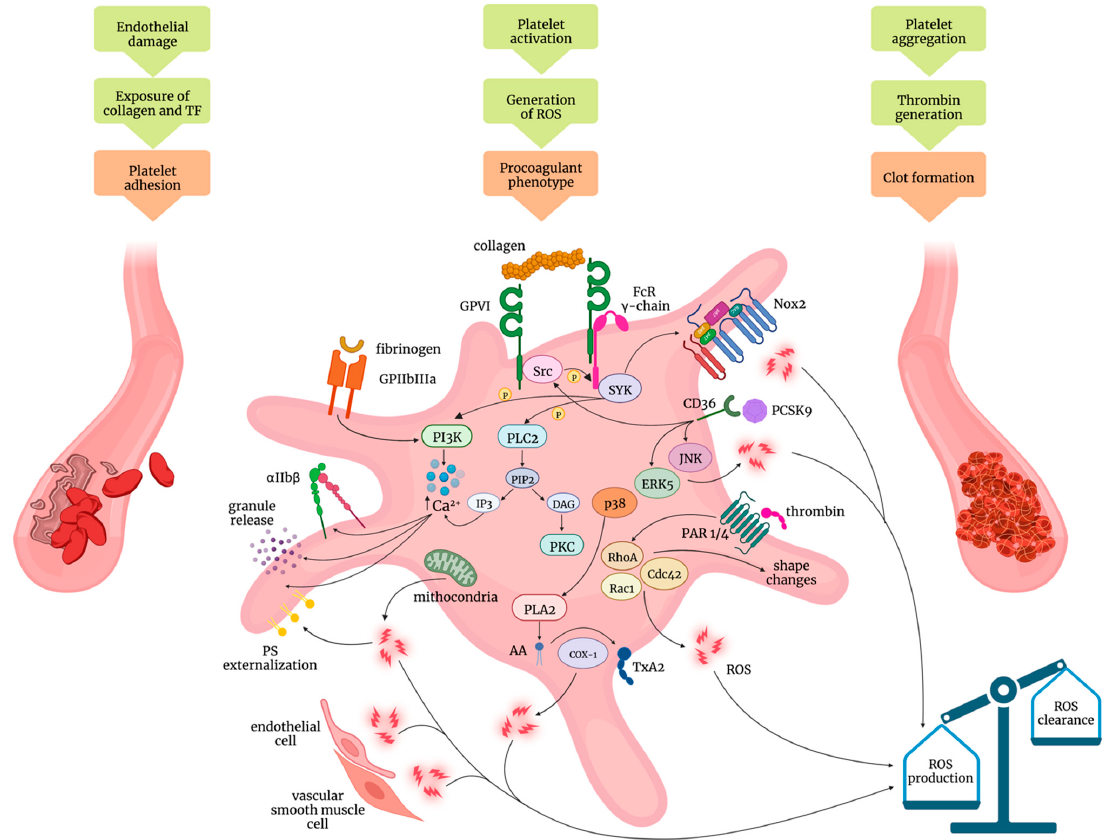
Figure 1. Platelet redox imbalance leading to a prothrombotic state. Major signalling pathways involved in platelet activation and increased ROS production. The imbalance between ROS production and ROS clearance causes oxidative stress and contributes to the generation of a prothrombotic state. Abbreviations: TF: tissue factor; ROS: reactive oxygen species; GPIIbIIIa: glycoprotein IIb/IIIa; PI3K: phosphoinositide 3-kinase; GPVI: glycoprotein VI; FcR γ -chain: Fc